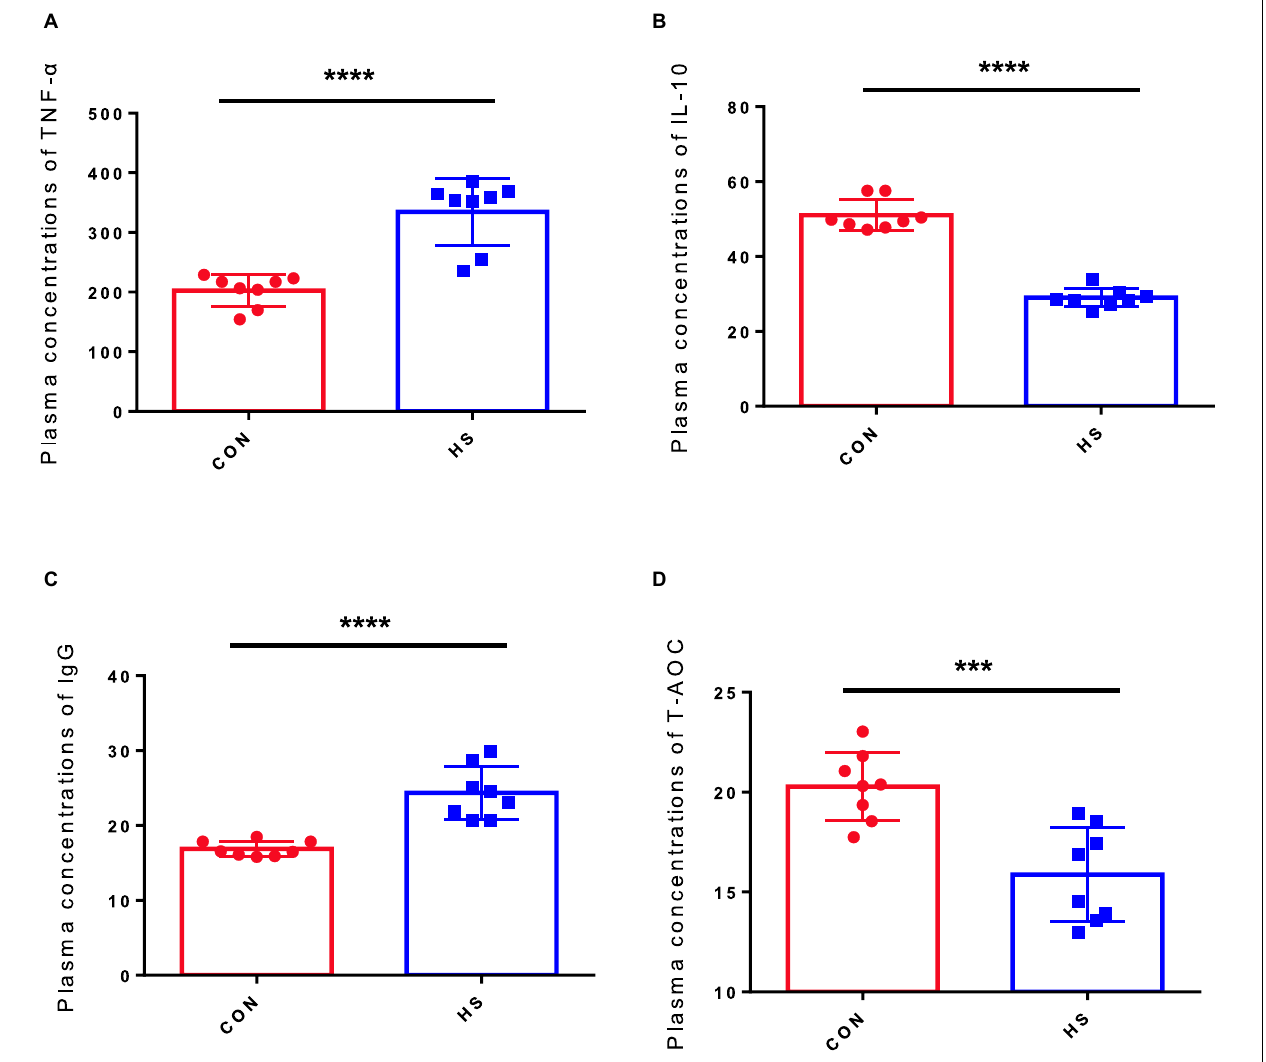
FIGURE 1 | Effect of HS on the serum hormone levels in rabbits. (A) IgG concentration in the serum; (B) IL-10 concentration in the serum; (C) TNF- α concentration in the serum; (D) T-AOC concentration in the serum. The asterisk symbols indicate significance (***) and more significant (*****).